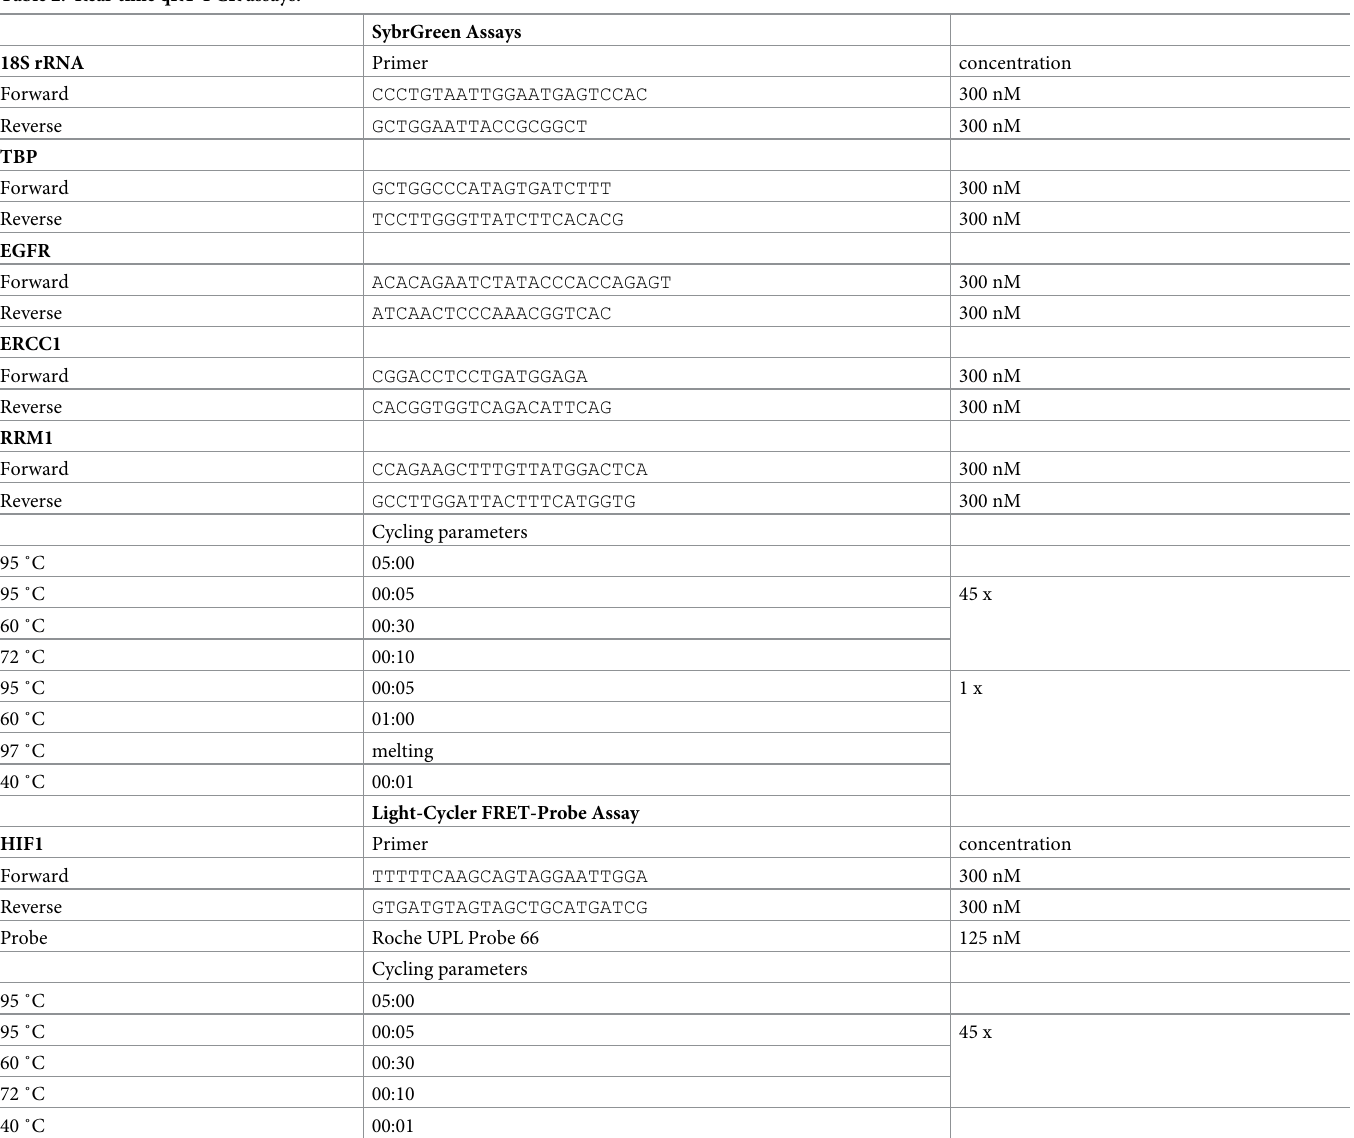
Table 2. Real-time qRT-PCR